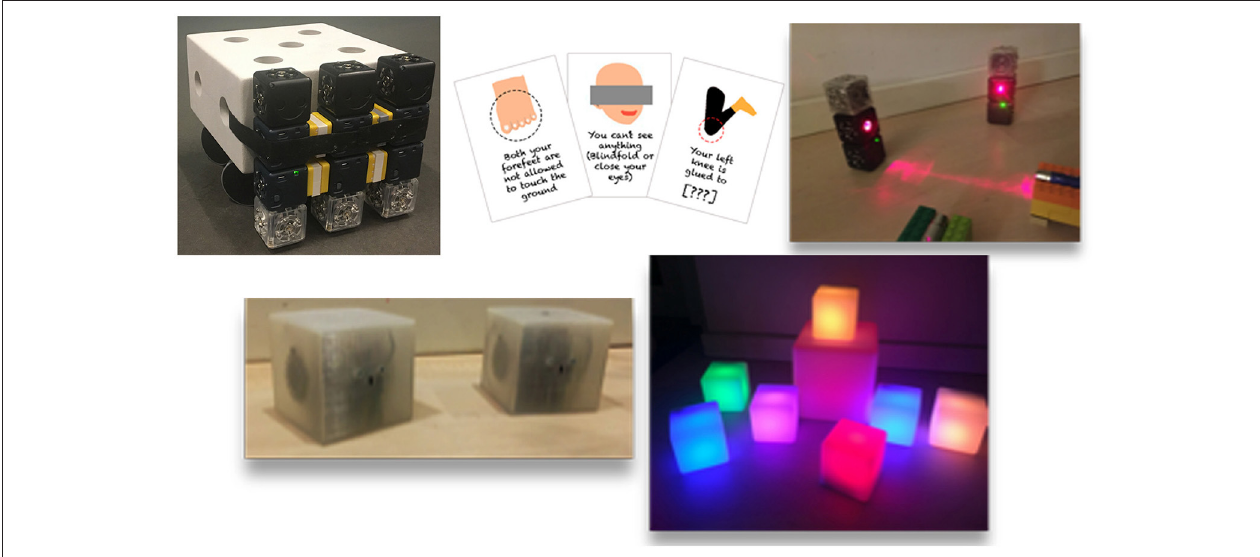
FIGURE 1 | Elements; top left image: The moving robot, top middle: Restraint cards, top right: Laser lines, bottom left: Music Cubes, bottom right: Light cubes.